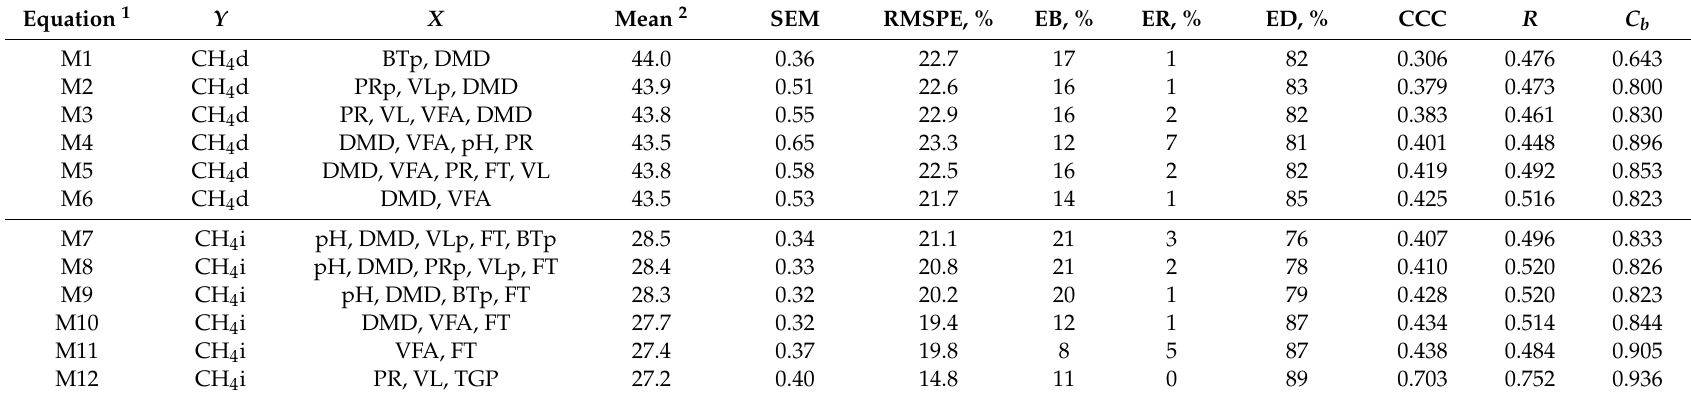
Table 4. Linear multivariate equations—meta-analysis model evaluation via root mean square prediction error (RMSPE) and concordance correlation coe ffi cient (CCC) analysis on the internal evaluation ( n = 107) database.